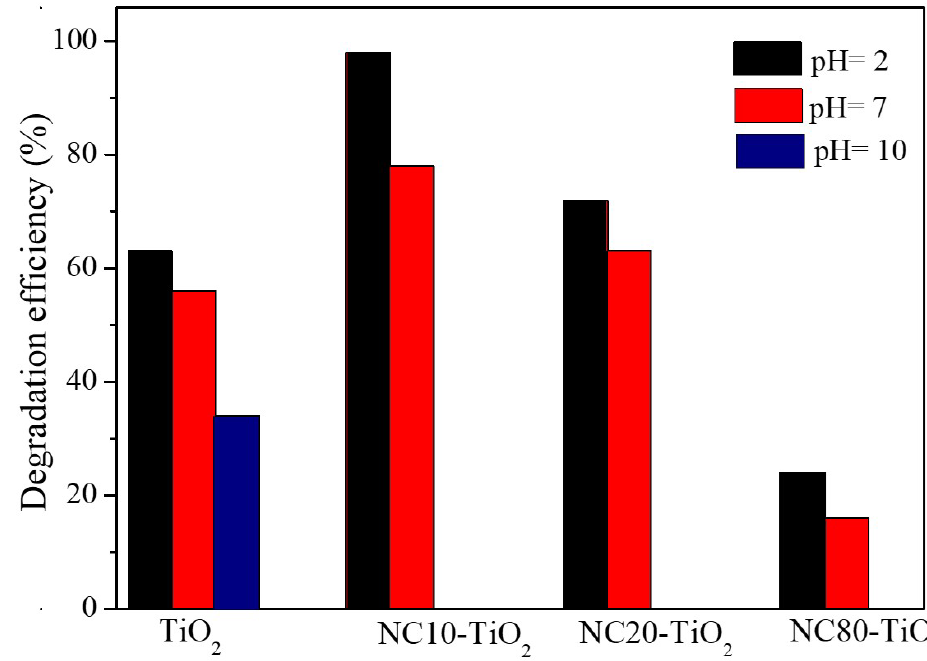
Figure 7. Percentages of the degradation efficiency for methyl orange obtained with different NC–TiO 2 nanocomposites and TiO 2 at different pH values.